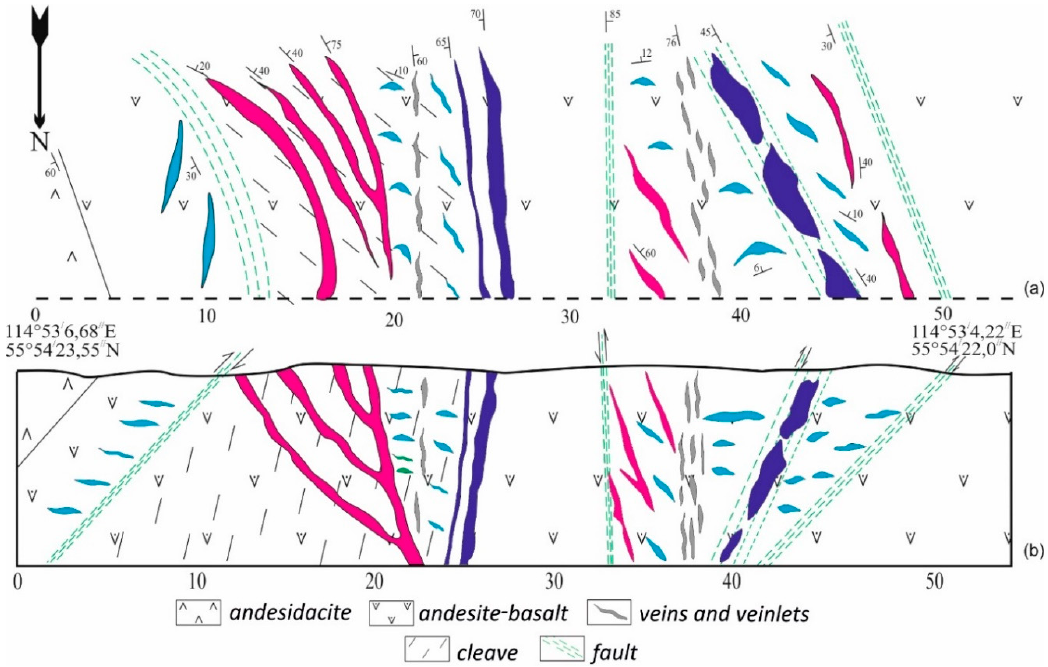
Figure 4. The structure of the quartz veins of the Otvesny zone: ( a ) Plan view; and ( b ) W–E profile. Blue color indicates the main veins, pink indicates syndeformational veins, and light blue color indicates submain veins.